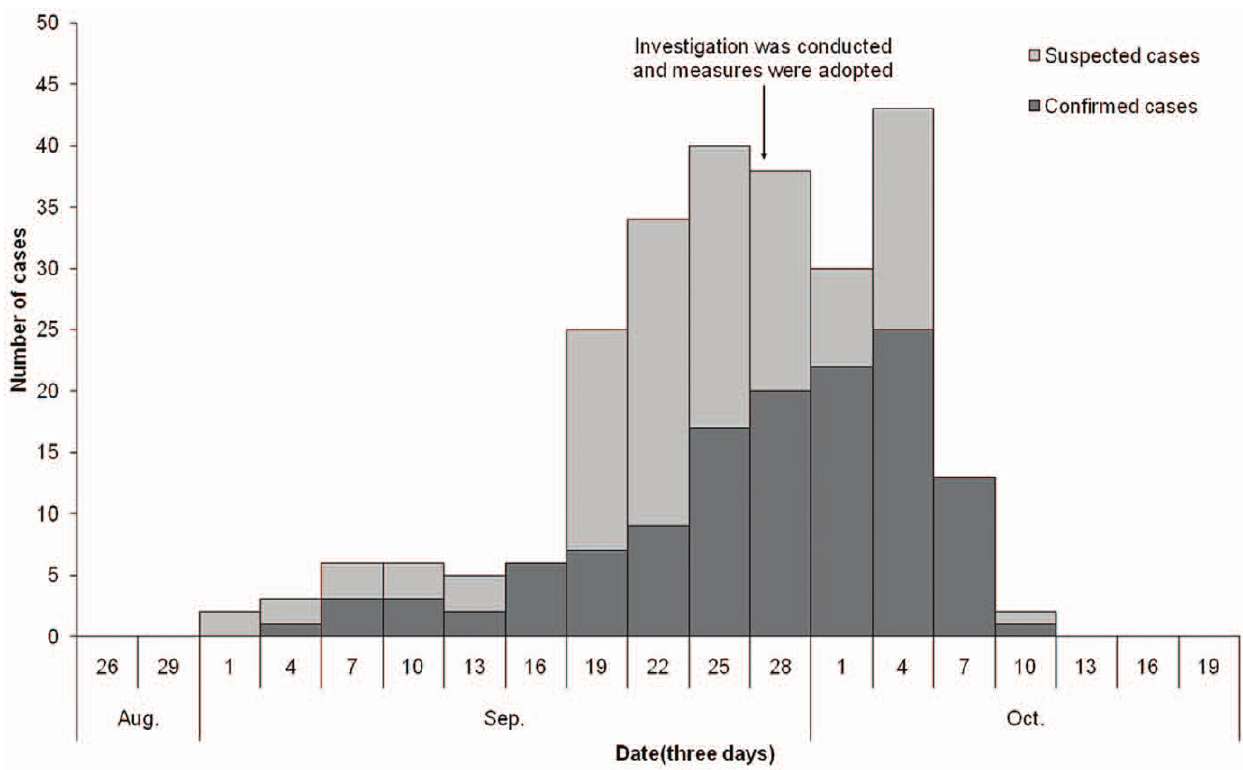
Figure 2. Temporal distribution of onset of cases during the CHIK fever outbreak in Xincun.